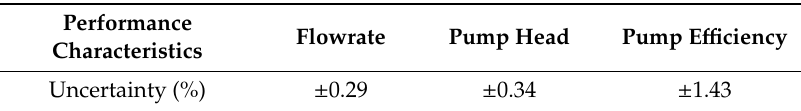
Table 3. Experiment overall uncertainty.